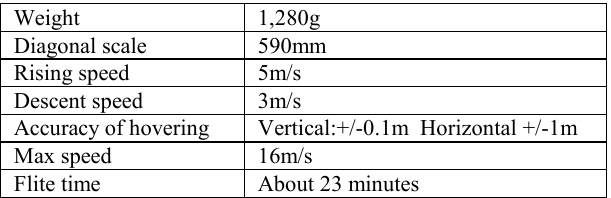
Table 1. UAV specifications